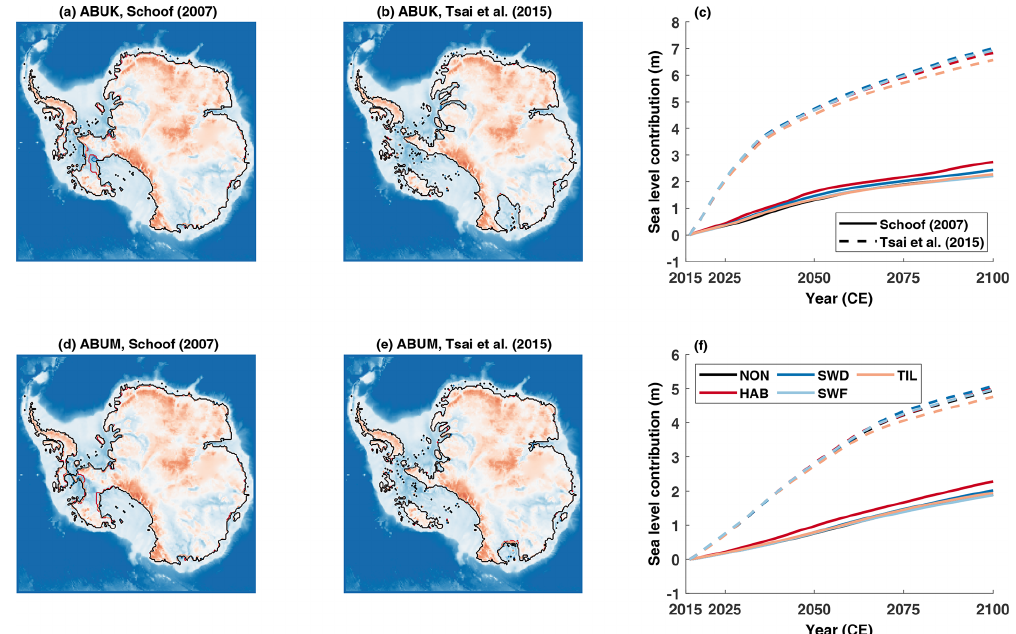
Figure 10. Grounding-line positions at 2100CE for ABUK and ABUM experiments for both grounding-line flux conditions (a, b, d, e) and associated mass loss over the same period ( c : ABUK, f : ABUM). In these experiments the exponent of the sliding law m is equal to 1. Line colours represent the different subglacial models (Table 2); solid lines represent a grounding-line flux parameterization due to Schoof (2007) (standard runs) and dashed lines one due to Tsai et al. (2015). Grounding-line positions in the left and middle panels are largely